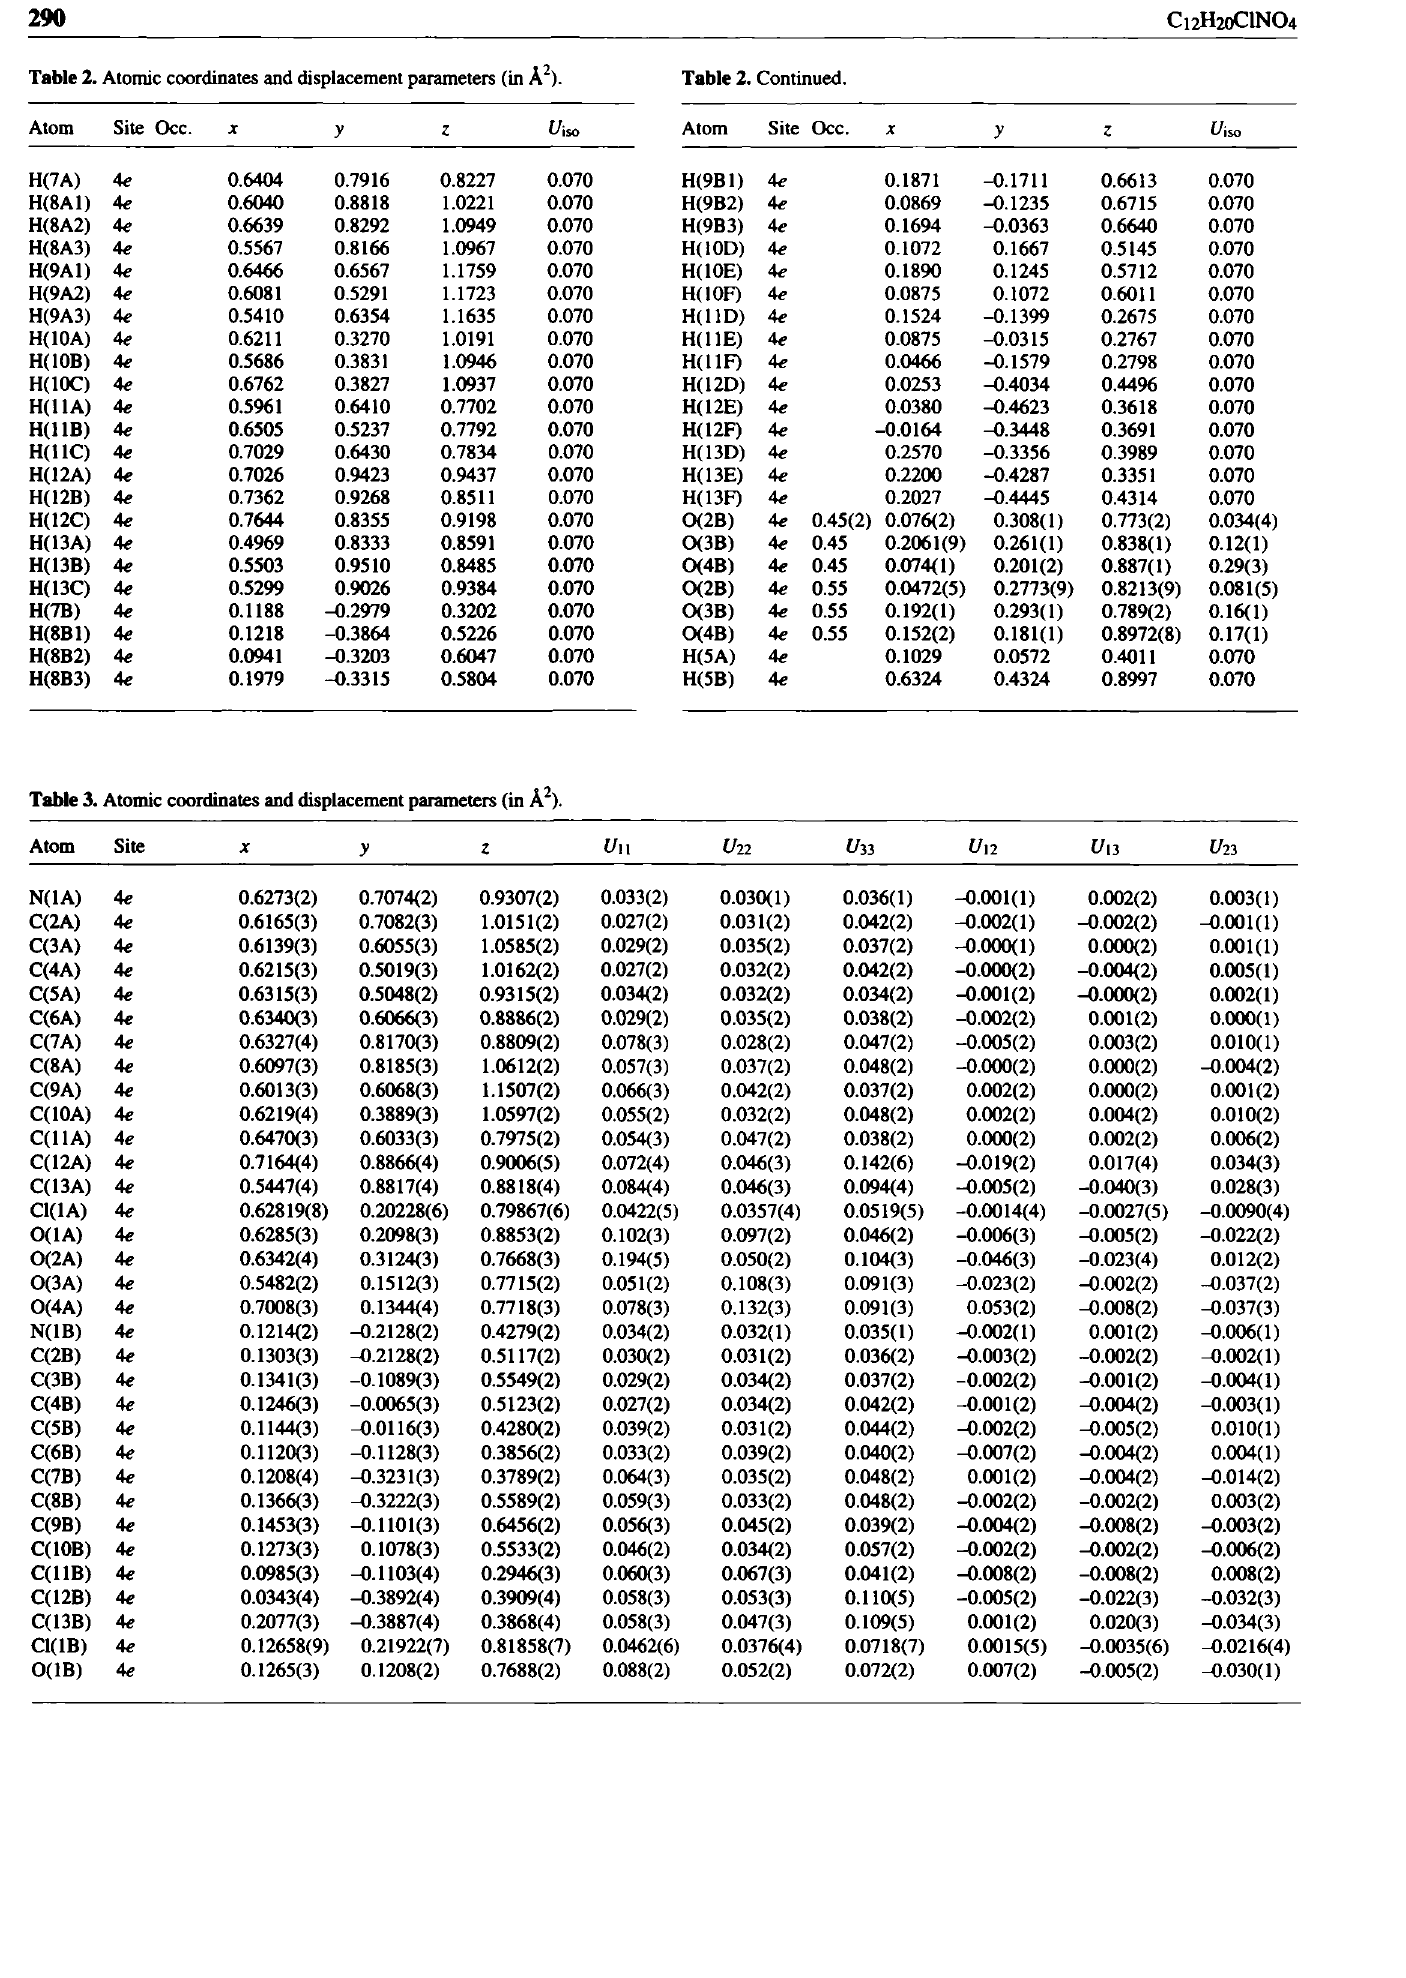
Table 3. Atomic coordinates and displacement parameters (in Â 2